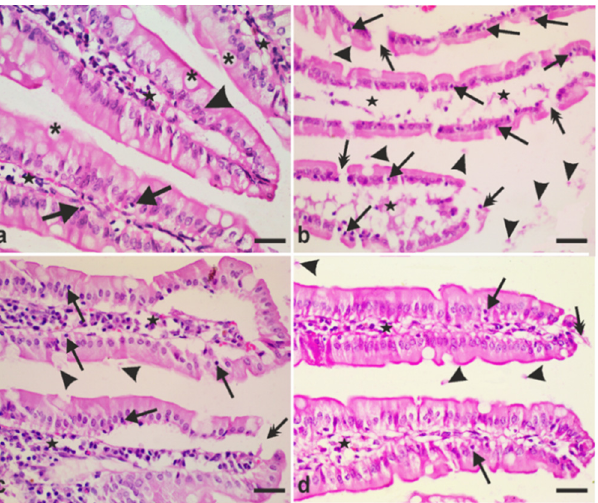
Figure 5. Representative photomicrographs of small intestinal tissues of different groups of hamsters stained with hematoxylin and eosin . ( a ) Representative tissue from uninfected animals showing intact intestinal villi that are covered with simple columnar epithelium (arrowheads) with goblet cells (asterisks), villi core (stars), and a few IELs (arrows). ( b ) Representative tissue from infected untreated animals showing disruption of the mucosal epithelium (double-headed arrows), marked increase in IELs (arrows), retracted villi core with a few scattered connective tissue cells (stars), and presence of giardia trophozoites between villi (arrowheads). ( c ) Representative tissue from infected animals treated with metronidazole showing mucosal epithelium with a few desquamated cells (double-headed arrows), regeneration of the villi core (stars), a few IELs (arrows), and giardia trophozoites in the intervillous spaces (arrowheads). ( d ) Representative tissue from infected animals treated with A. annua showing preserved intestinal villi with a few desquamated cells (double-headed arrows) and intraepithelial lymphocytes (arrows). Stars point to intact villi core, whereas arrowheads point to a few giardia trophozoites found between the villi. Scale bar = 30 µm.